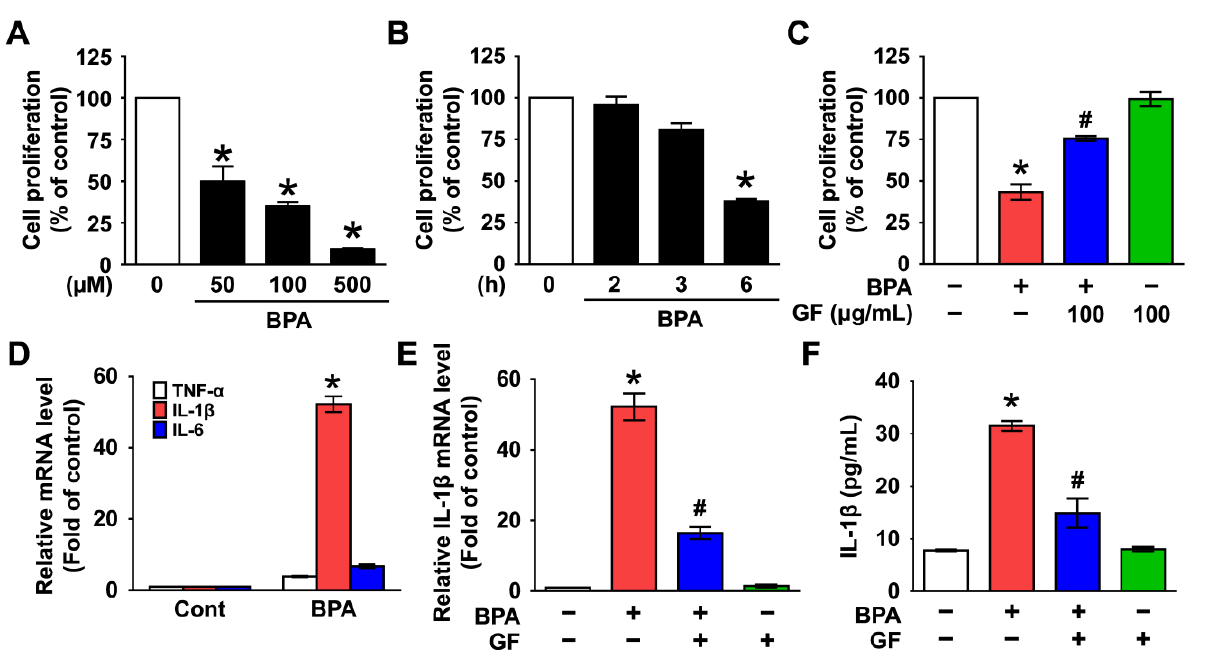
Figure 1. Inhibitory effect of Grifola frondosa (GF) on skin cytotoxicity and inflammation stimulated by bisphenol A (BPA). ( A ) Dose-dependent response of cell viability in normal human dermal fi- broblasts (NHDFs) treated with BPA (0 –500 μM) are shown. The cell viability was determined by EZ-CYTOX assay. n = 3. * p ≤ 0.05 vs. 0 μM. ( B ) Time-dependent response of cell viability treated